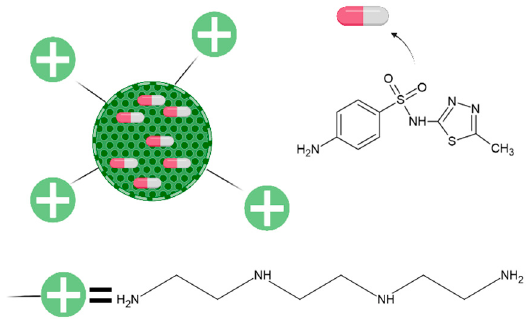
Figure 1. TEM images of MSN sample at different magnifications.